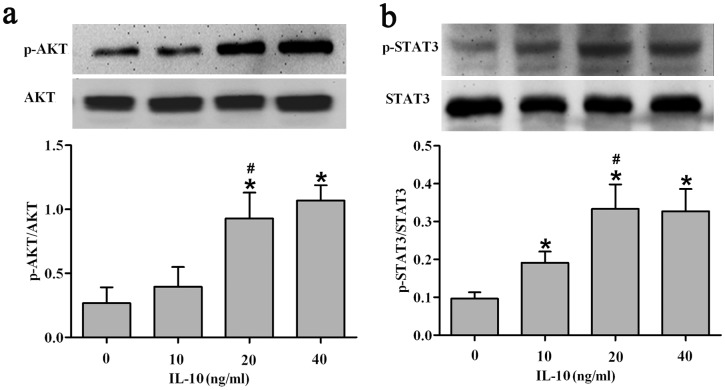
Concentration-dependent phosphorylation of AKT/STAT3 by IL-10 in HSFs.(a, b) Concentration-dependent phosphorylation of AKT (a) and STAT3 (b) in IL-10-treated HSFs. After a 30-min incubation with various doses of IL-10, cells were harvested and analyzed by Western blotting. Data are expressed as the mean ± SEM (n = 3, *p<0.05 vs. control, #p<0.05 vs. HSFs treated with IL-10 at 10 ng/ml).